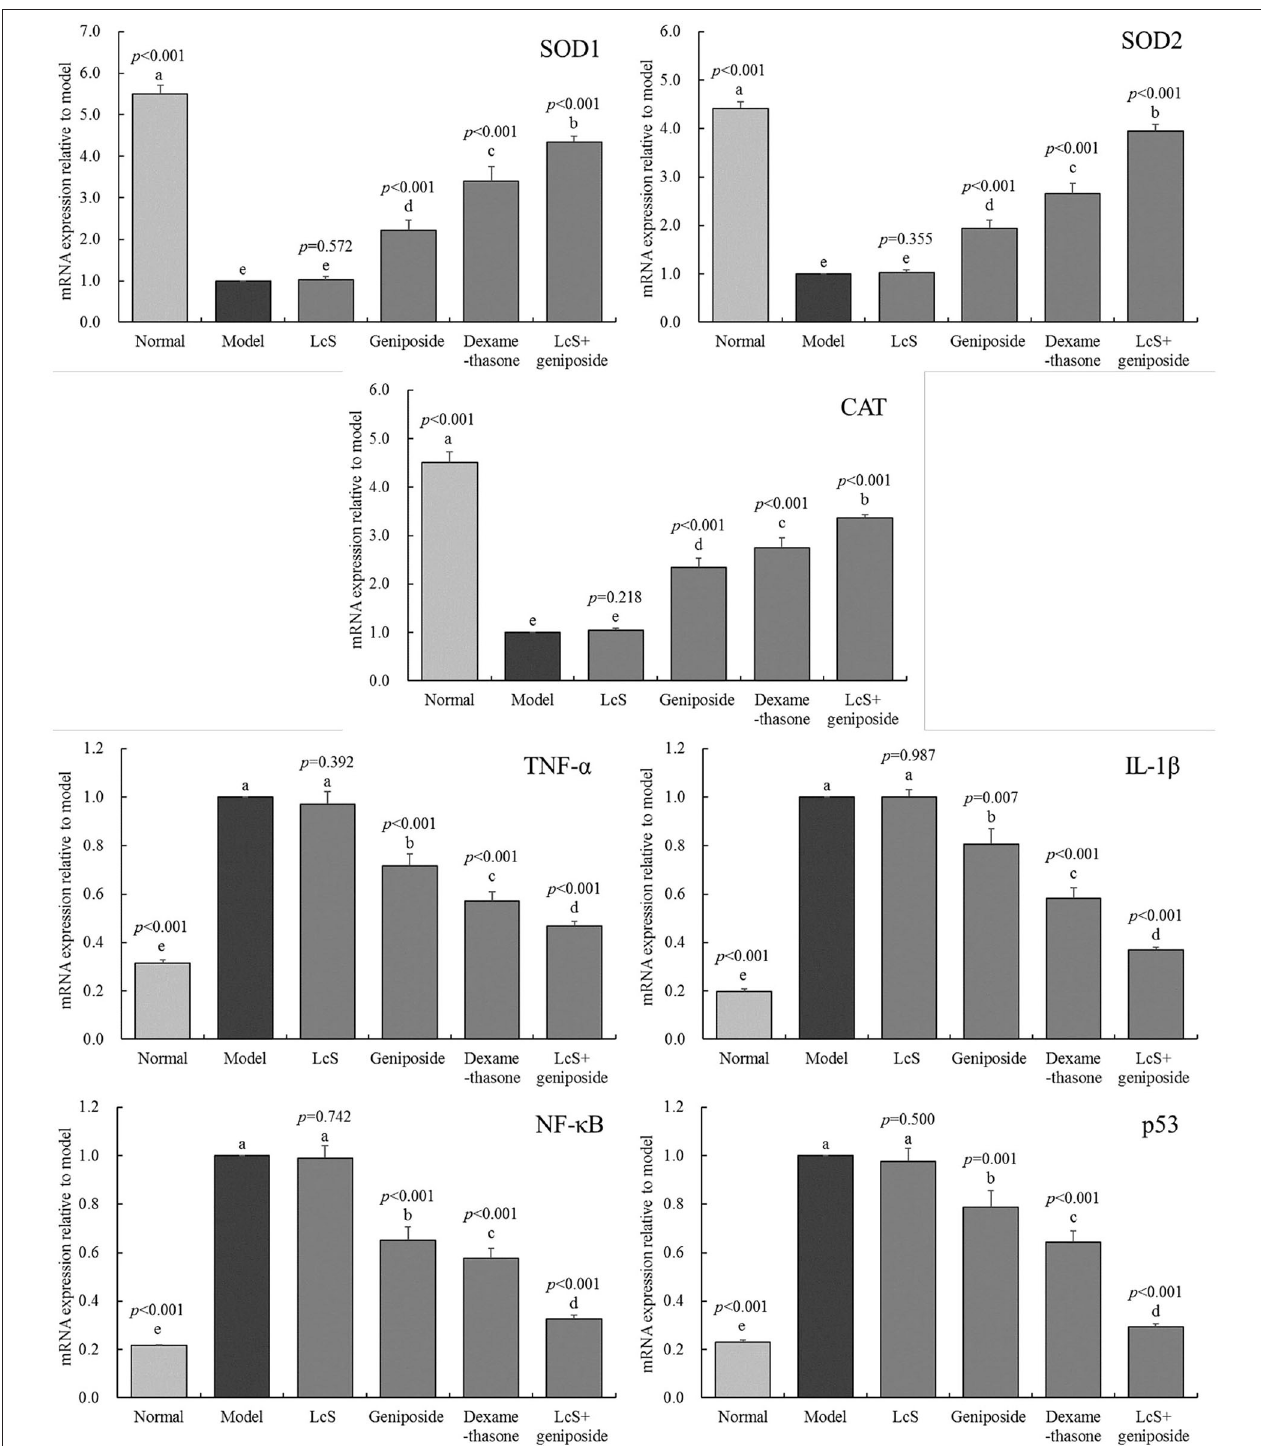
FIGURE 6 | SOD1, SOD2, CAT, MDA, TNF- α , IL-1 β , nuclear factor kappa beta (NF- κ B and p53 mRNA expression of the hippocampus of mice with sepsis on the seventh day ( n = 3). The mean values are tabulated with mean ± standard deviation, and the p -value is the relative situation of the corresponding group to the model group. Normal: untreated mice; model: mice with induced sepsis, LcS: 5 × 10 7 CFU/kg-treated mice with sepsis; geniposide: 50 mg/kg geniposide-treated mice with sepsis; dexamethasone: 1 mg/kg dexamethasone-treated mice with sepsis; LcS + geniposide: 5 × 10 7 CFU/kg LcS and 50 mg/kg geniposide-treated mice with sepsis. a − e Mean values with different letters over the bar are significantly different ( P < 0.05) according to Tukey’s honestly significant difference test.